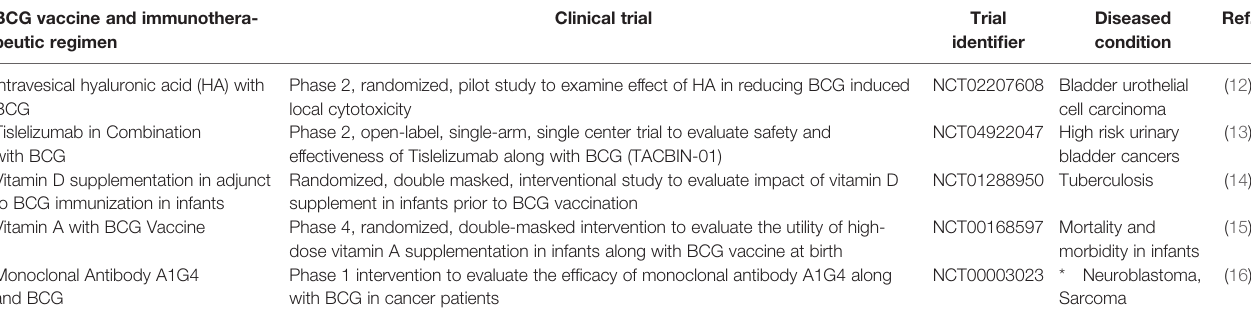
Clinical trial Trial